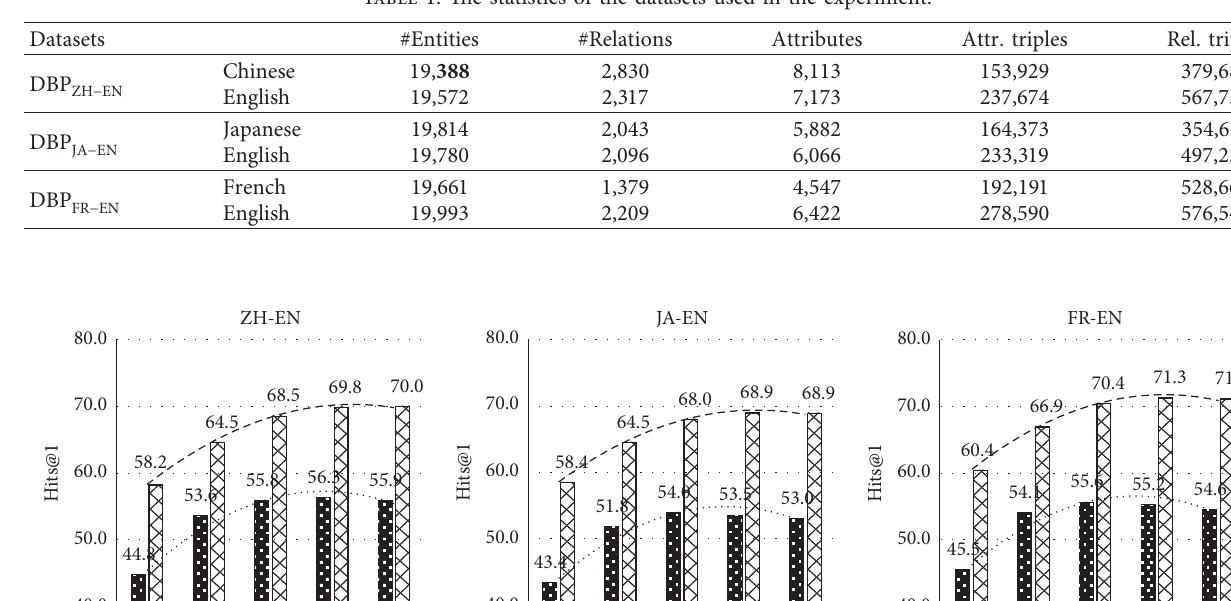
ZH-EN . (b) DBP JA-EN . (c) DBP FR-EN .